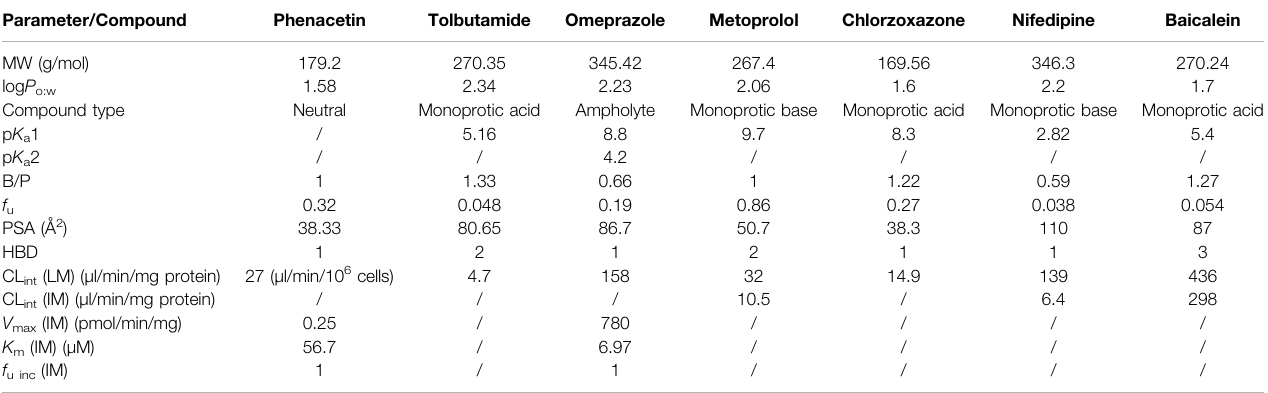
TABLE 2 | Input parameters in the PBPK models.